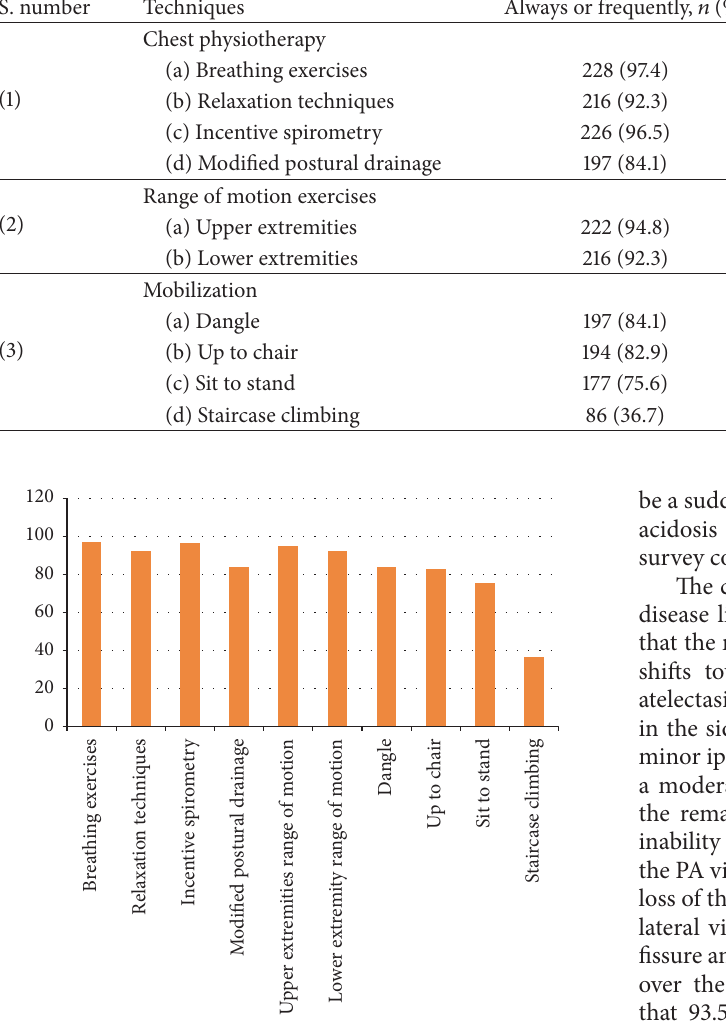
Figure 7: Physiotherapy interventions used on the 3rd postopera- tive